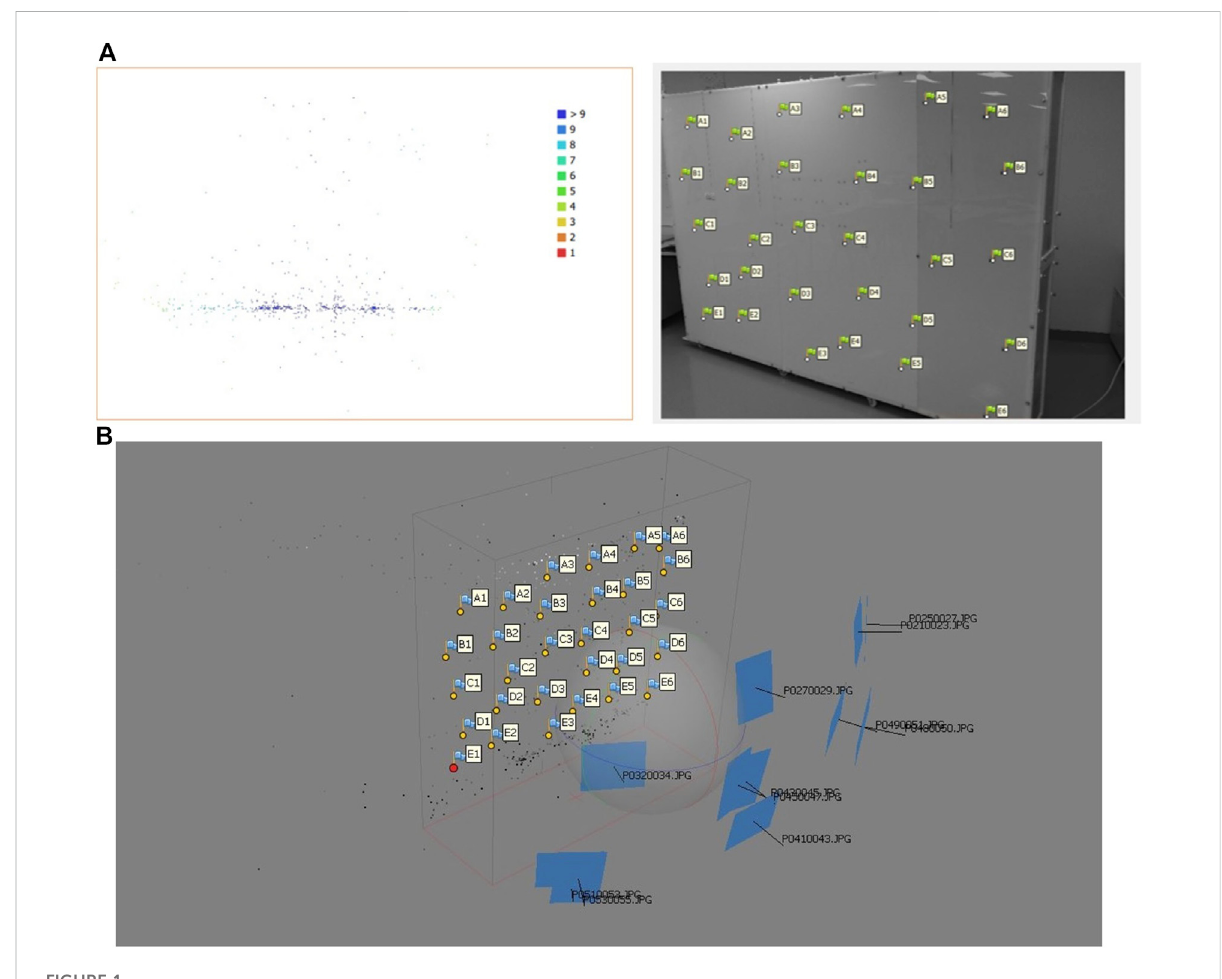
Figure 2. After applying the camera calibration steps, the error results were determined. The Parrot Ana fi thermal camera was calibrated, and the drone was ready to be used for photogrammetric mapping. The perspective location of exposure stations, and camera orientation, are shown in Figure 1B using Agisoft